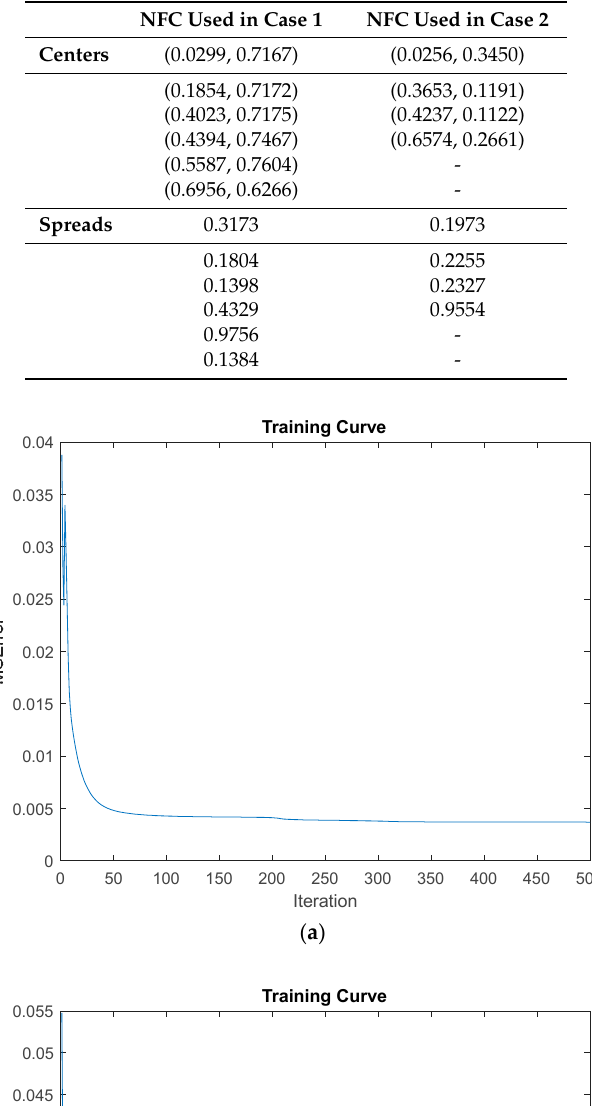
Table 3. Clustering results by the UAC process conducted in cases 1 and 2.